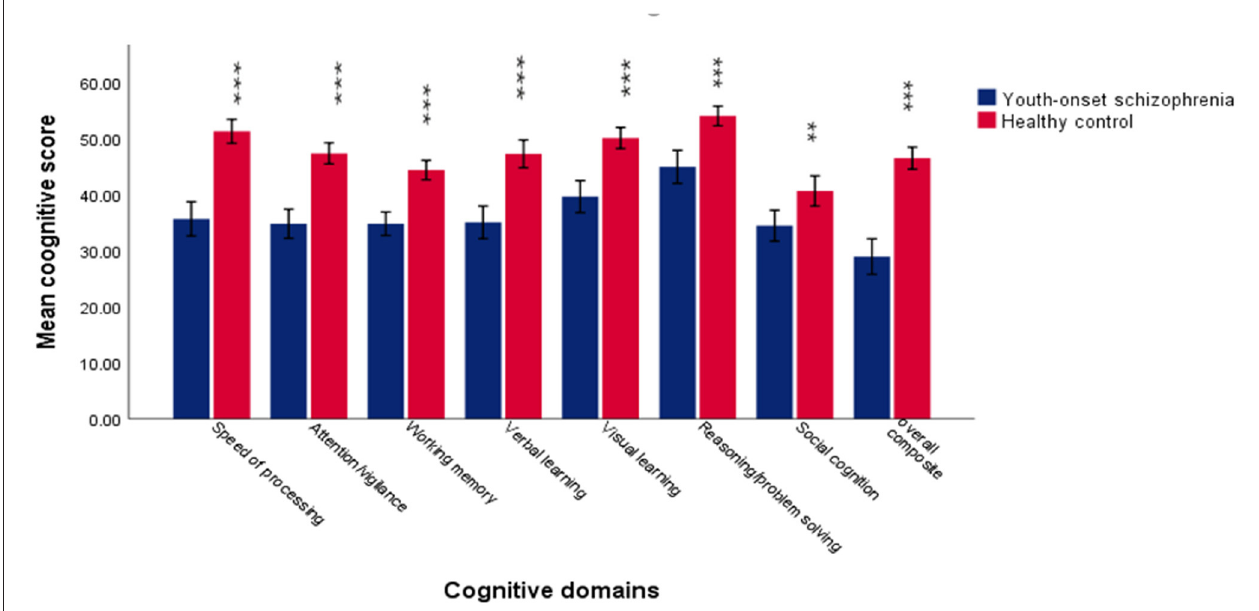
FIGURE 1 | The difference in each cognitive domain between youth-onset schizophrenia and healthy control. The results suggested that patients exhibited significantly lower scores on all the cognitive domains of MCCB. ***Represent p < 0.001. **Represent p < 0.05. Error bars represent standard